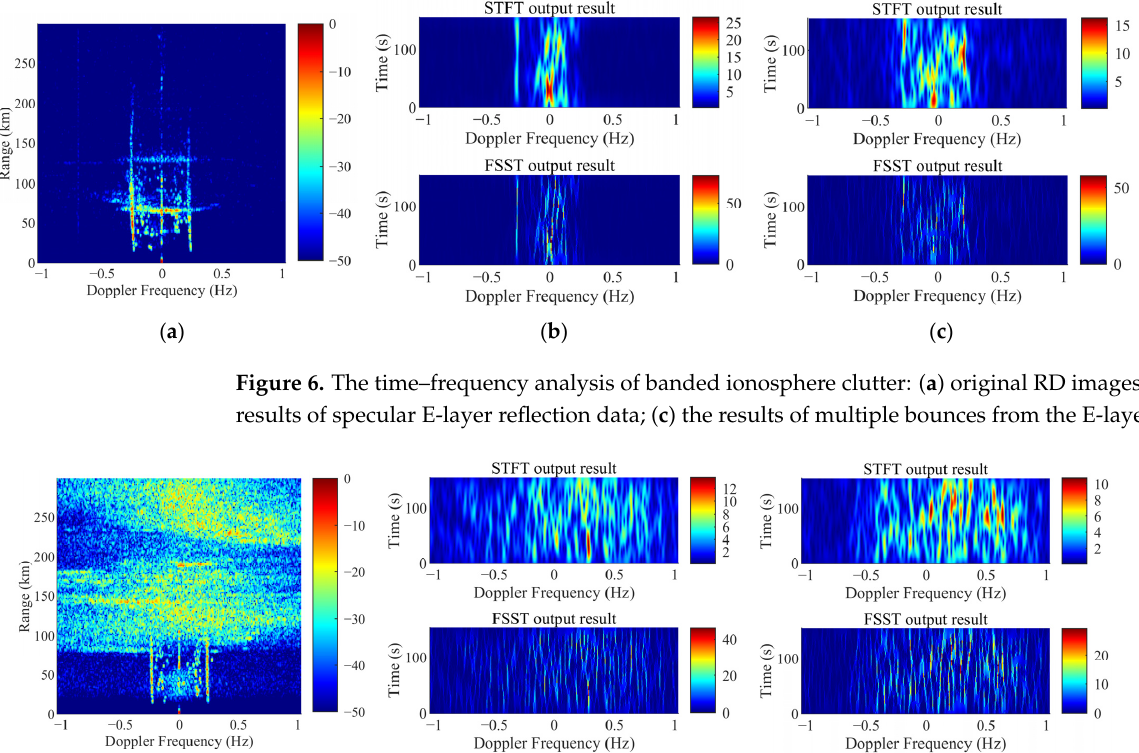
Remote Sens. 2022 , 14 , 3424 12 of 20